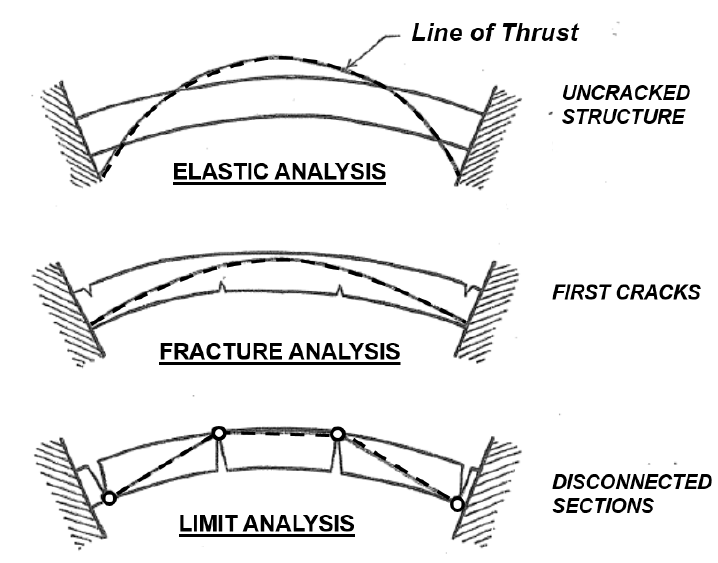
Figure 1. Elastic-fracture-plastic transitions in masonry arches: softening and fracturing process.